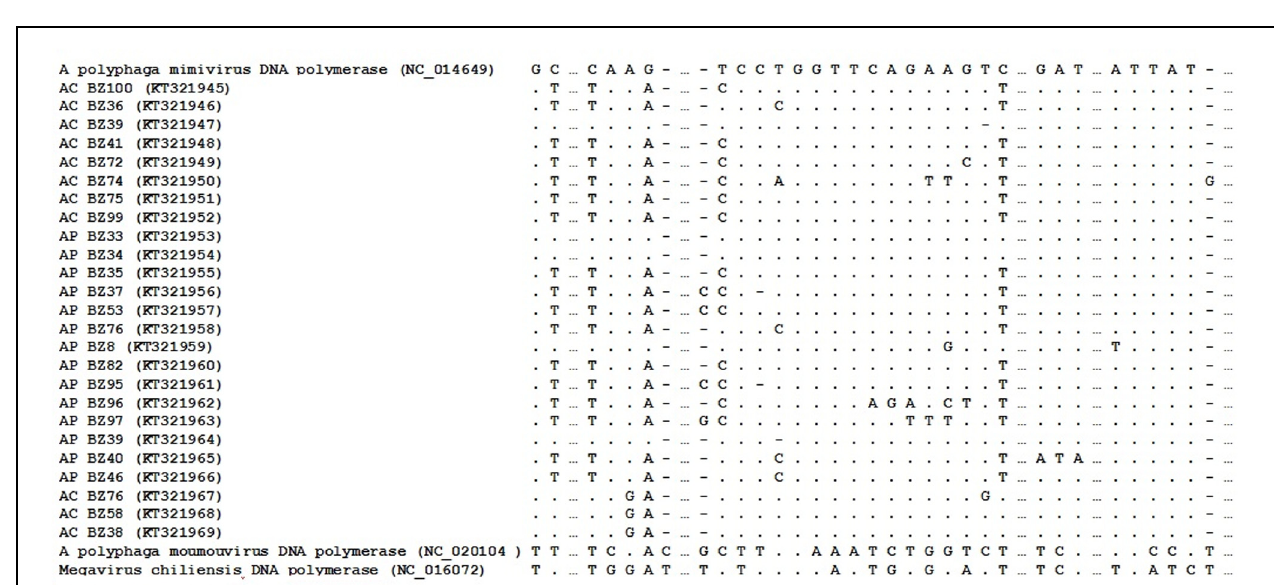
FIGURE 3 | Nucleotides sequence of a fragment of the mimivirus DNA polymerase B gene. Samples obtained in this study are underlined; boldface indicates polymorphic.